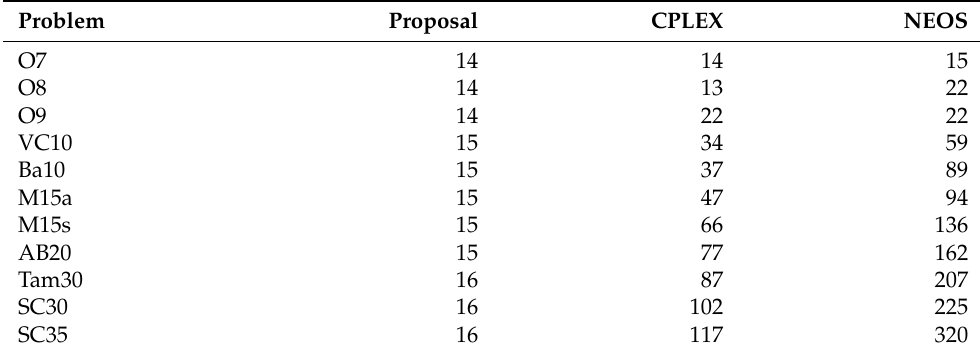
Table 4. Average CPU TIME for computing an optimal arrangement under relative-constraints ( µ